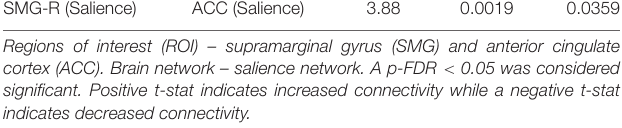
TABLE 4 | Correlation between changes in mindfulness scores and functional connectivity in meditators. ROI (Network) ROI (Network) T-stat p-unc p-FDR SMG-R (Salience) ACC (Salience) 3.88 0.0019 0.0359 Regions of interest (ROI) – supramarginal gyrus (SMG) and anterior cingulate cortex (ACC). Brain network – salience network. A p-FDR < 0.05 was considered significant. Positive t-stat indicates increased connectivity while a negative t-stat indicates decreased